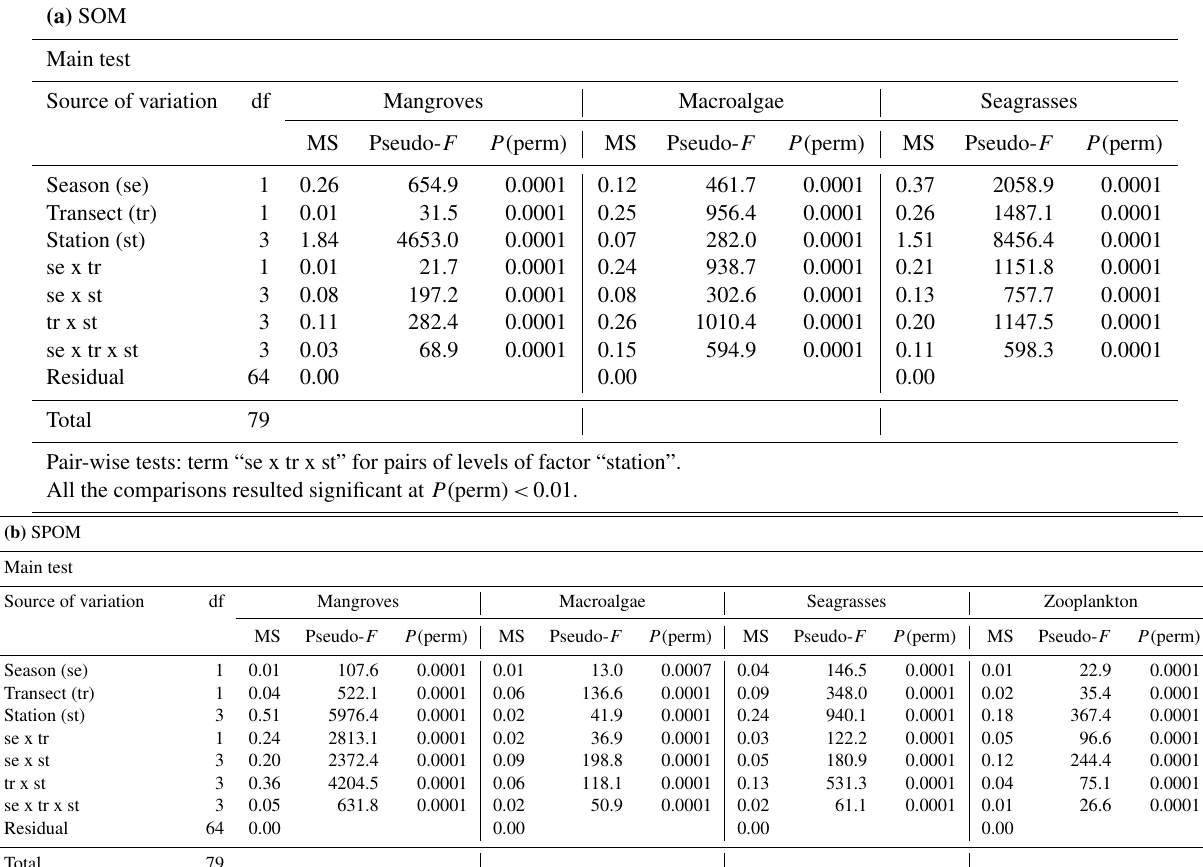
Table 1. Results of PERMANOVA main tests and pair-wise tests (9999 permutations) for organic matter source contribution to SOM (a) and SPOM (b) . df: degree of freedom; MS: mean square; P (perm): permutational probability values.